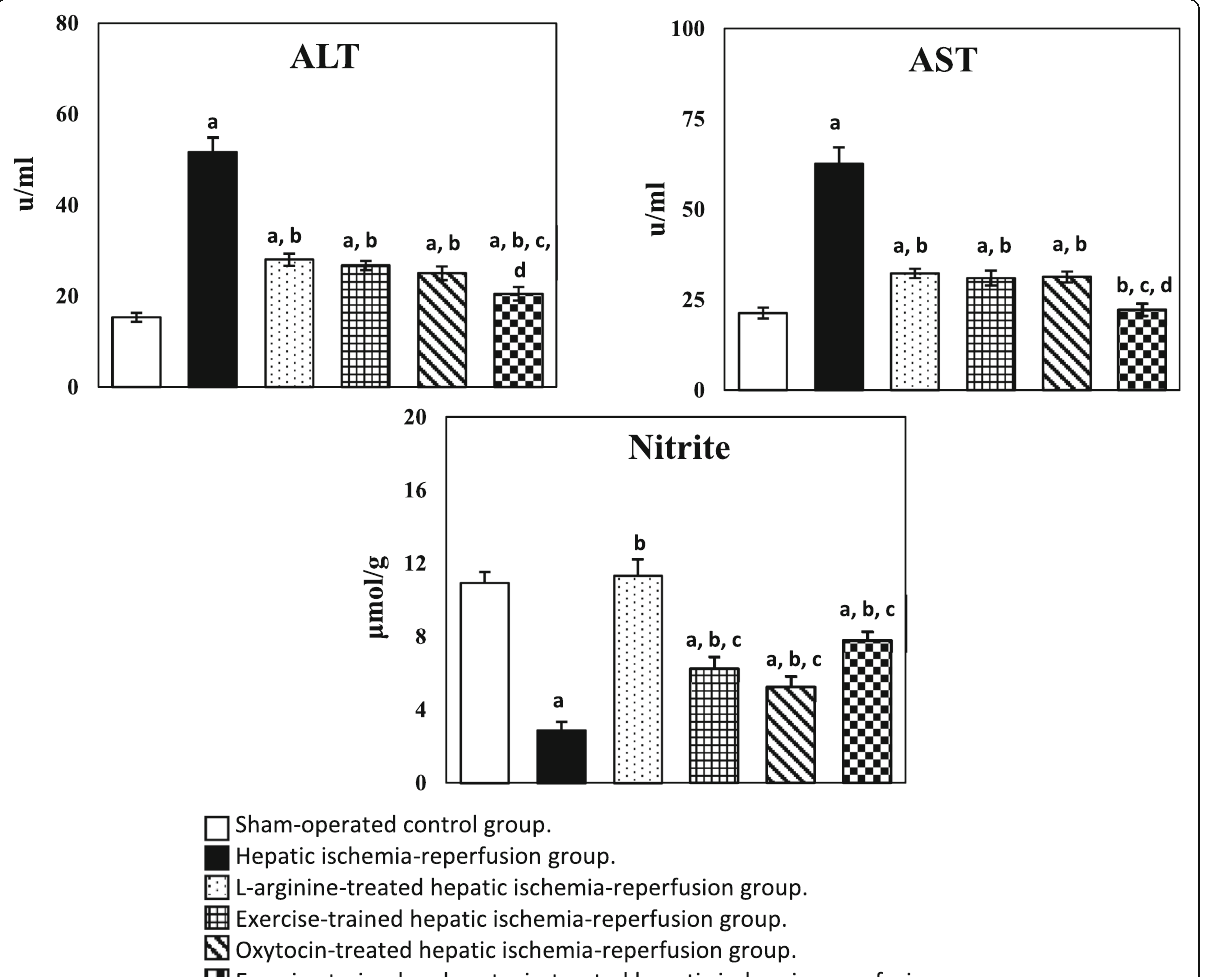
Fig. 1 Serum levels of alanine transferase (ALT), aspartate transferase (AST), and plasma level of the nitrite in the different studied groups. a Significance from the sham-operated control group calculated by LSD at P <0.05. b Significance from the hepatic ischemia-reperfusion group calculated by LSD at P <0.05. c Significance from the L -arginine-treated hepatic ischemia-reperfusion group calculated by LSD at P <0.05. d Significance from the exercise-trained hepatic ischemia-reperfusion group calculated by LSD at P